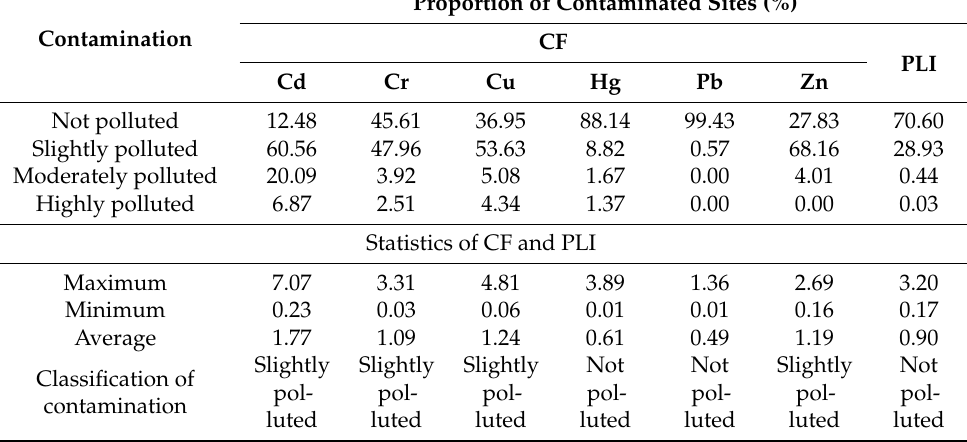
Table 7. Classes and statistics for the contamination factor (CF) and pollution load index (PLI) for six heavy metals in